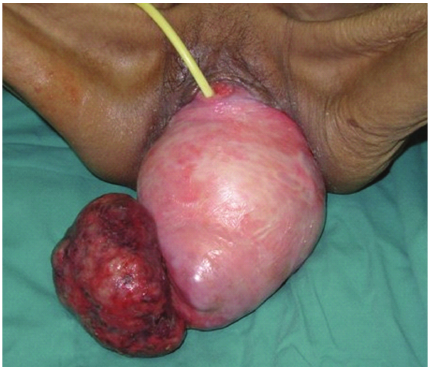
Figure 1: Massive irreducible uterovaginal prolapse with a huge cervical